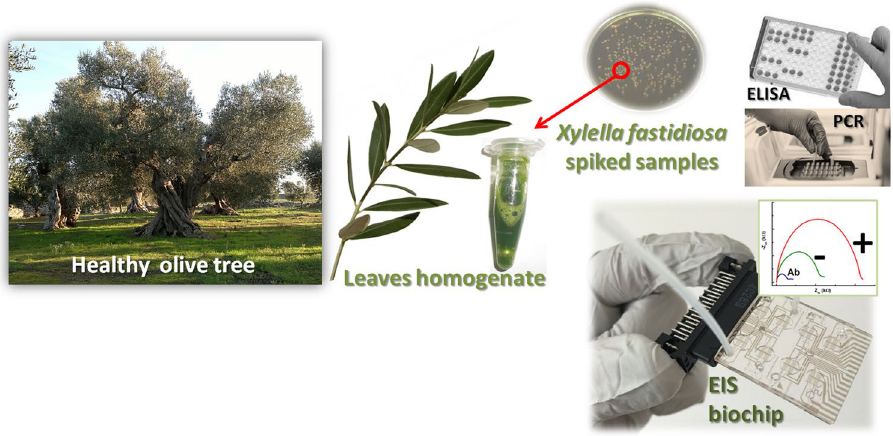
Figure 1. Spiked olive leaves homogenates and real samples (healthy or naturally infected) were tested with two standard techniques and a LOC platform in order to validate the on-chip method for Xylella fastidiosa